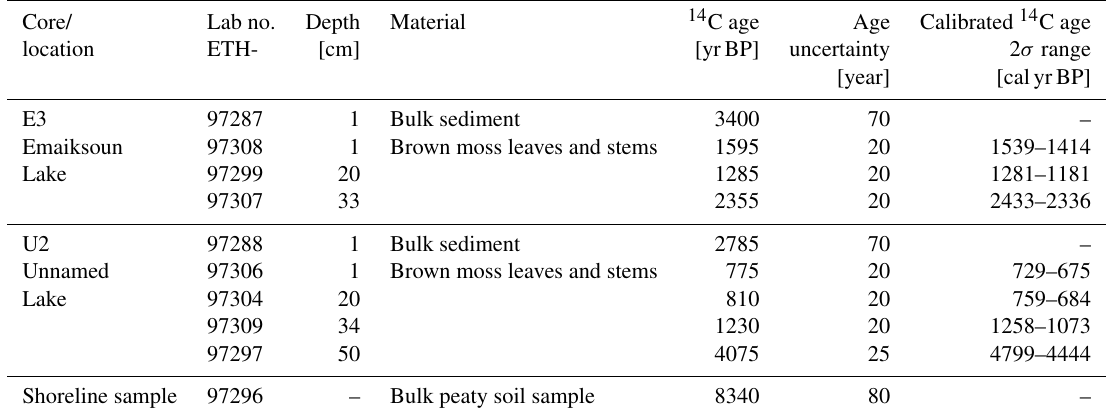
Table 2. Details of radiocarbon data from sediment cores E3 and U2 and one shoreline sample. The calibrated age ranges were calculated with IntCal20 (Reimer et al.,